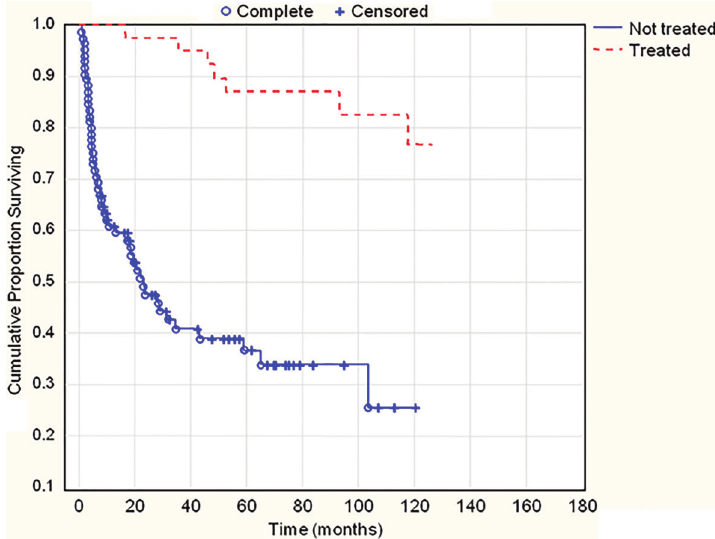
Figure 2. Cumulative survival (Kaplan-Meier) of interferon-treated versus untreated patients who had recurrent hepatitis C viral (HCV) infection after orthotopic liver transplantation. Survival was sig- ni fi cantly better in those who received recurrent HCV treatment (P o